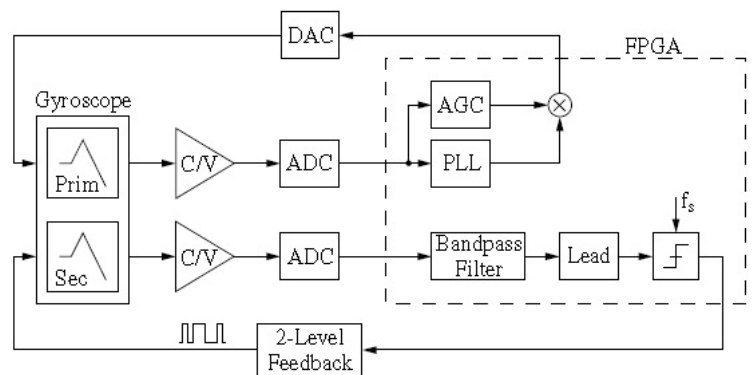
Figure 36. HSG-IMIT ΣΔ modulation